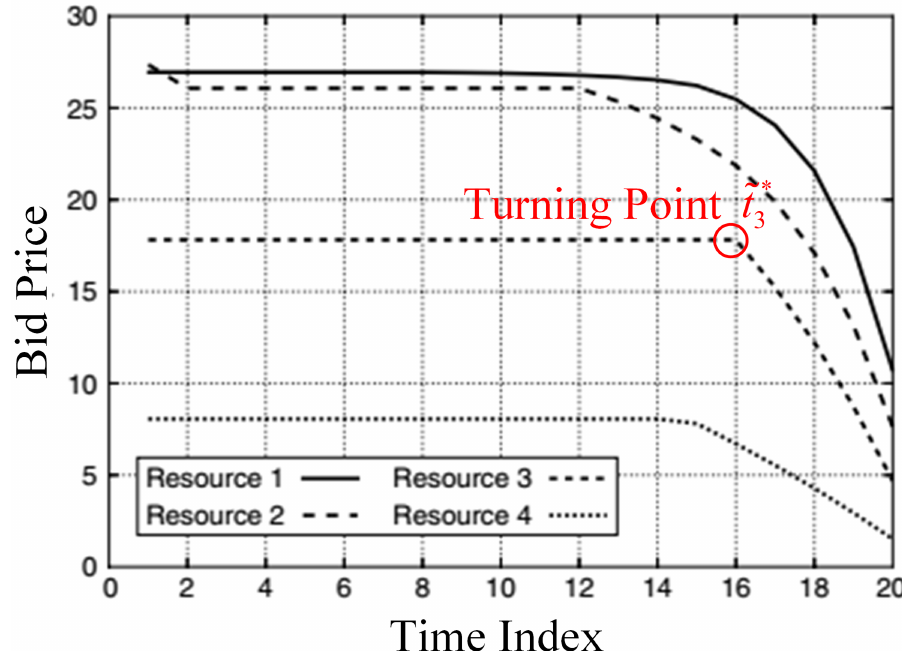
Fig 7. An example of dynamic bid price